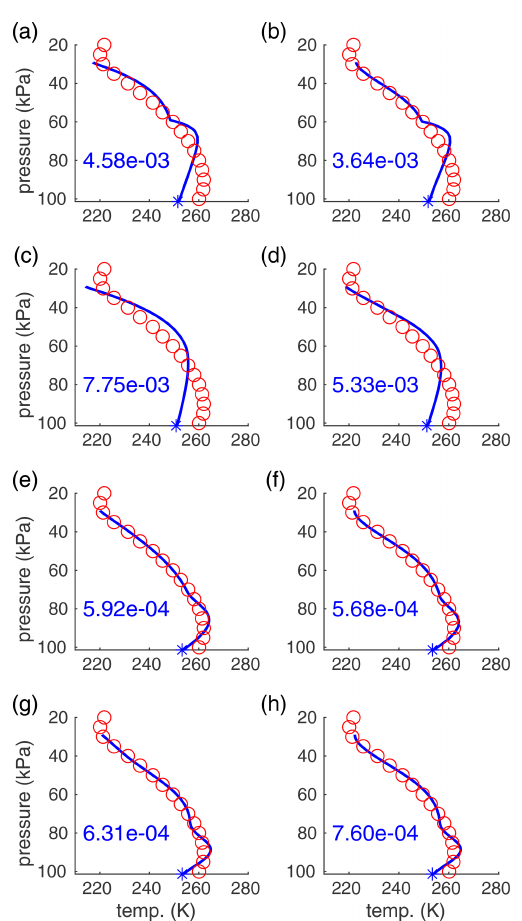
Figure B1. Model calibrated to global average values. The vertical axis in all the plots is the pressure. (a) Energy transport via radiative terms, and latent and sensible heat. (b) Atmospheric temperature. The red asterisk marks the surface temperature, T S . (c) Atmospheric heat transport, F A . (d) Vertical wind speed. (e) Density.